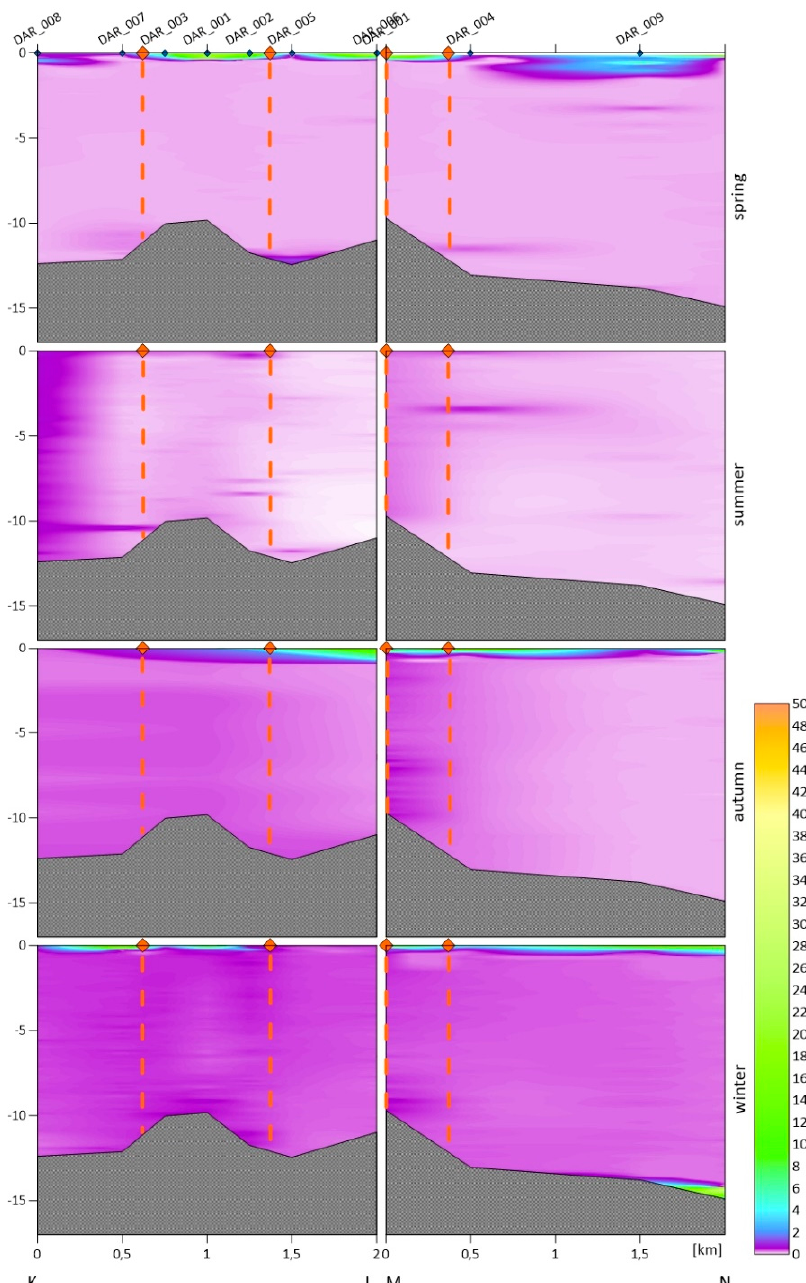
Figure 4. Vertical cross-sections of the turbidity of the seawater obtained based on the in situ measurements conducted along the KL and MN sections. The orange points at the sea surface and dashed lines are the borders of the Darłowo dumpsite; the measurement points along the transects are marked in blue on the top axis.